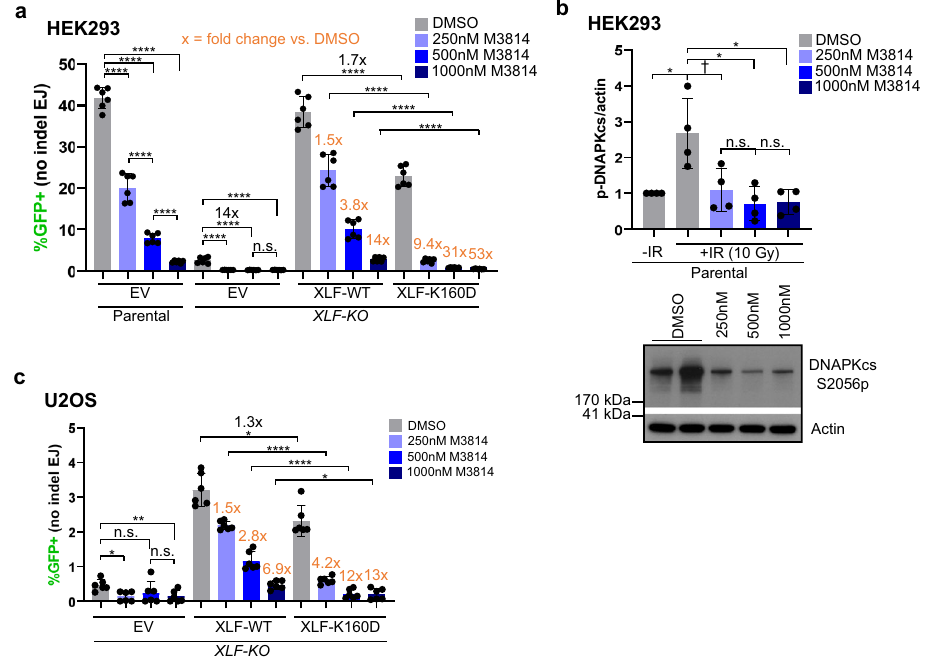
Fig. 2 Inhibiting DNAPKcs kinase activity suppresses No Indel EJ to a greater degree when combined with XLF-K160D. a Effect of DNAPKcs kinase inhibitor M3814 on No Indel EJ in HEK293 cells with XLF-WT, XLF-K160D, and without XLF. Control cells treated with DMSO (the vehicle for M3814). n = 6 biologically independent transfections. Statistics with unpaired two-tailed t test using Holm – Sidak correction. **** P < 0.0001, n.s. = not signi fi cant. Fold-effects are shown to facilitate comparisons of the effect of each M3814 treatment on XLF-WT vs. K160D. b M3814 decreases ionizing radiation (IR)- induced phosphorylation of DNAPKcs at S2056 (S2056p). Shown are levels of DNAPKcs-S2056p normalized to Actin, and a representative immunoblot. n = 4 biologically independent wells of seeded cells. Statistics as in ( a ). DMSO − IR vs + IR * P = 0.0142, DMSO + IR vs. 500 nM M3814 + IR * P = 0.0497, DMSO + IR vs. 1000 nM M3814 + IR * P = 0.0497, DMSO + IR vs. 250 nM M3814 + IR † P = 0.0328 but not signi fi cant after correction (unadjusted P - value), n.s. = not signi fi cant. c The in fl uence of DNAPKcs kinase inhibition with XLF-K160D is similar in U2OS cells. n = 6 biologically independent transfections. Statistics as in ( a ). **** P < 0.0001, EV DMSO vs. EV 1000 nM M3814 ** P = 0.00311, EV DMSO vs. EV 250 nM M3814 * P = 0.0116, XLF-WT DMSO vs. XLF-K160D DMSO * P = 0.042, XLF-WT 1000 nM M3814 vs. XLF-K160D 1000 nM * P = 0.0169, n.s. = not signi fi cant. Data are represented as mean values ±